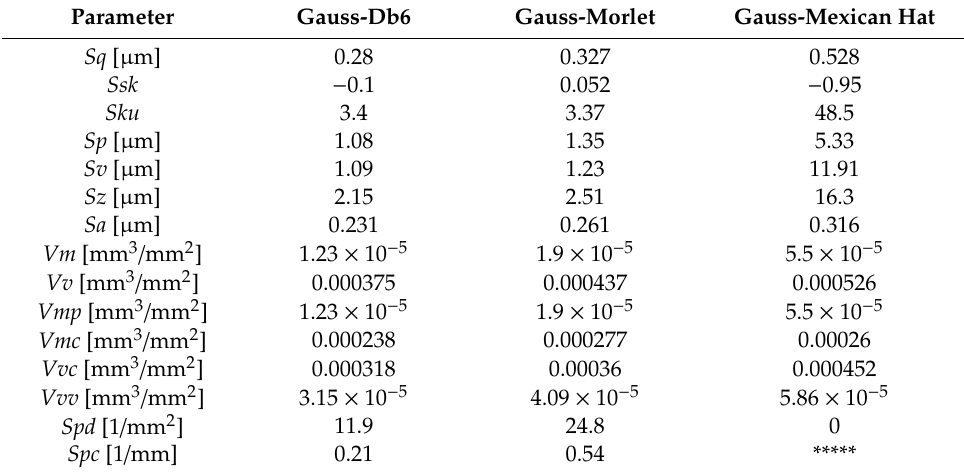
Figure 21. The surface was created as a result of subtracting the structure obtained with the wavelet from the structure after applying Gaussian filtration: ( a ) Daubechies wavelet 6, ( b ) Morlet wavelet, ( c ) Mexican hat wavelet. The root mean square error: ( a ) 0.28 μm, ( b ) 0.32 μm, ( c ) 0.53 μm. Table 4. Selected spatial parameters, calculated for surfaces shown in Figure